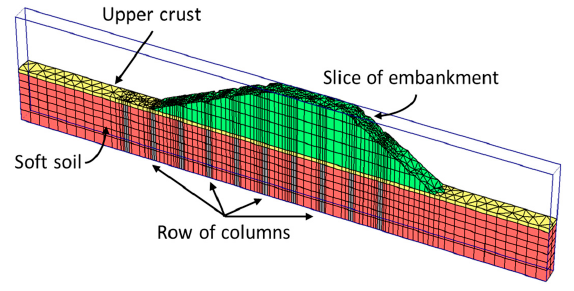
Figure 12. Finite element model of a 3D slice of columns.